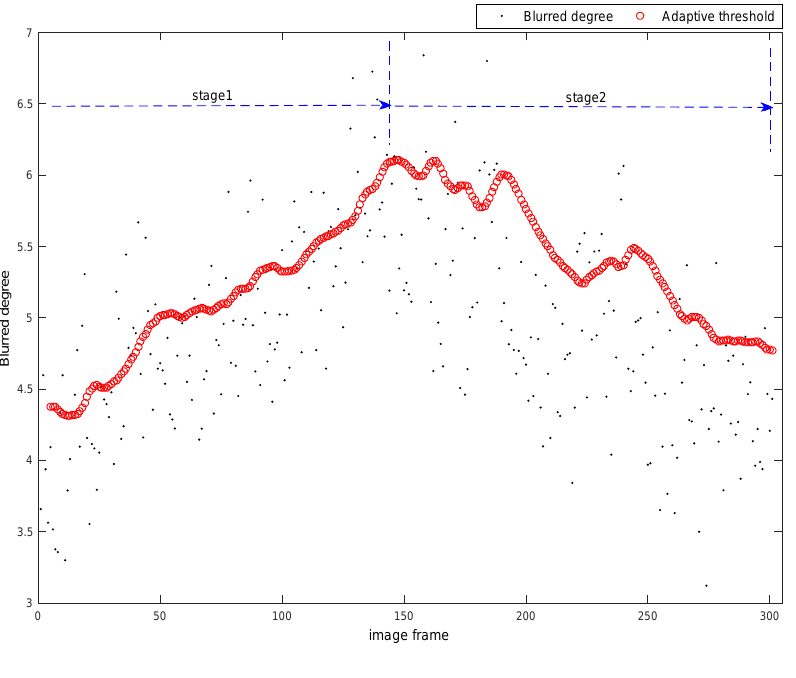
Figure 12. Classification results on the dataset captured by our